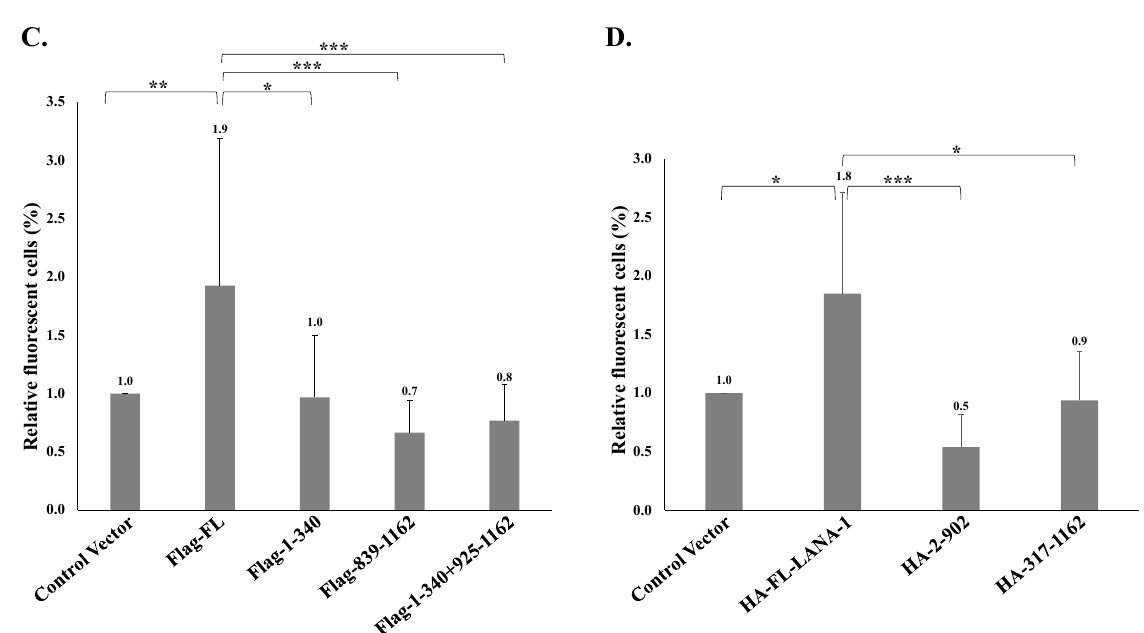
Figure 12. Prior expression of full-length LANA-1 is necessary to promote latency establishment. ( A ) Schematic diagram of the latency-associated nuclear antigen 1 (LANA-1) protein and fragments. HEK-293T cells were transfected with Flag or HA-tagged expression plasmids encoding different regions and full-length LANA-1. To identify the transfected cells, cells transfected with Flag-tagged expression plasmids were co-transfected with an EGFP expression plasmid, while the HA-tagged expression plasmids co-expressed ZsGreen fluorescent protein. After 24 h, the cells were infected with BAC16-mCherry viruses at an MOI of 0.25 using spinoculation. Cells were harvested 48 h after infection and the expression of LANA-1 and its corresponding fragments was analyzed by WB ( B ). The percentage of cells expressing mCherry in EGFP and ZsGreen-positive cells was measured by FACS. The value of cells transfected with a control plasmid was normalized to 1 and all samples were compared to this sample. The graph was prepared based on the average of 12 experiments for ( C ), and 8 experiments for ( D ). Statistical analysis was performed using the one-way ANOVA test and Tukey’s post hoc analysis tests. * p < 0.05, ** p < 0.01 *** p < 0.001.